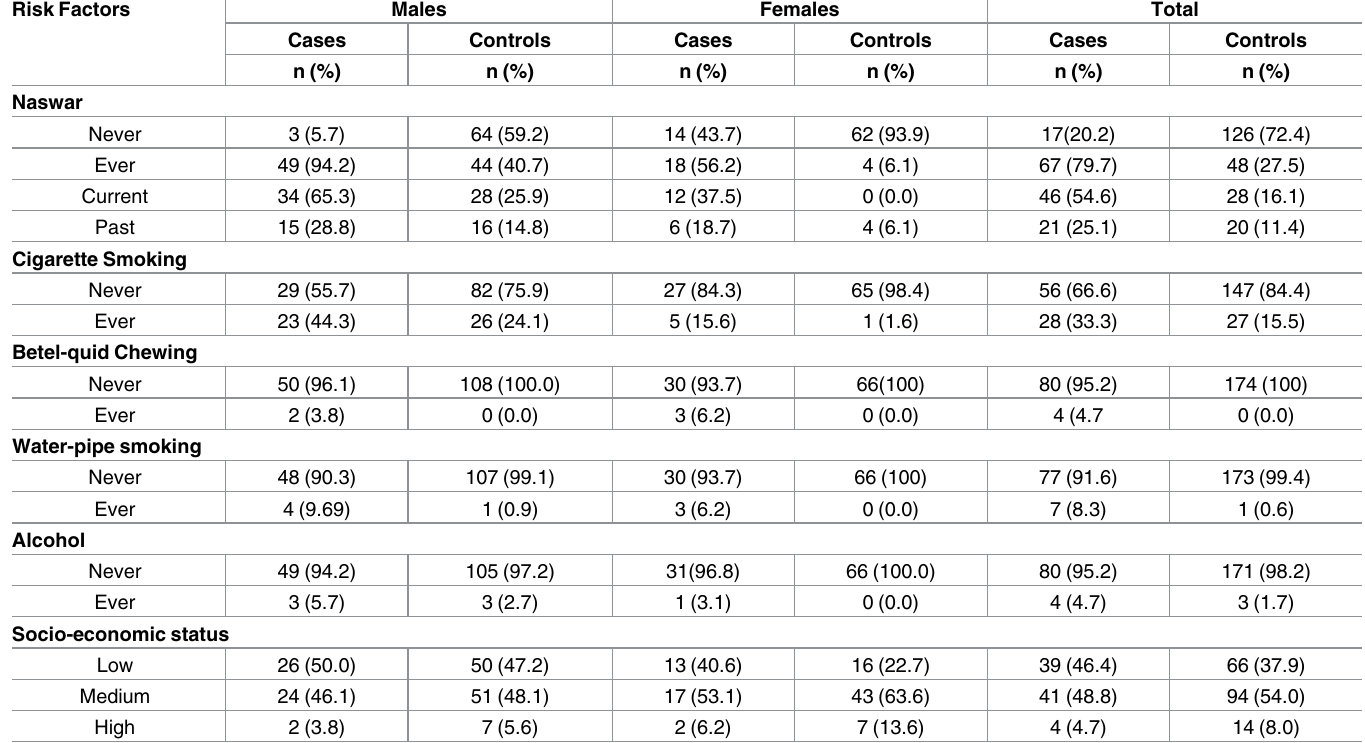
Table 2. Distribution of the lifestyle risk factors for oral cancer, by sex, among cases(n = 84) and controls (n = 174) in Khyber Pakhtunkhwa,